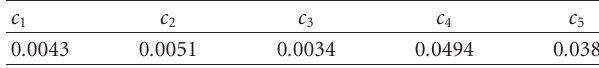
Table 1: Parameter values for the